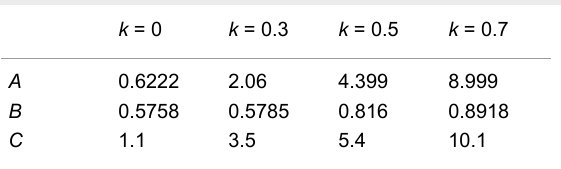
Table 1: Values of the coefficient A , B and C in the linear